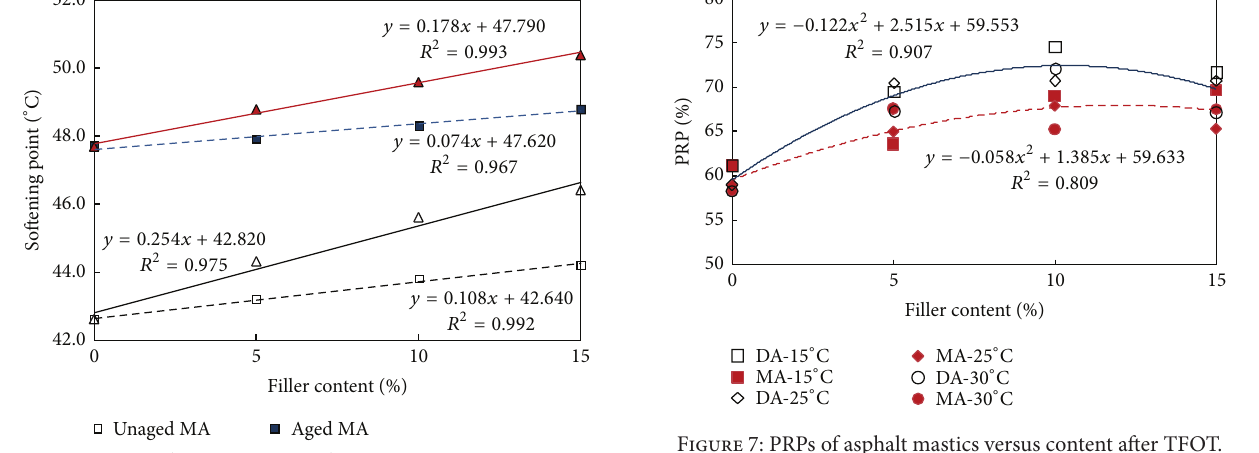
Figure 7: PRPs of asphalt mastics versus content after